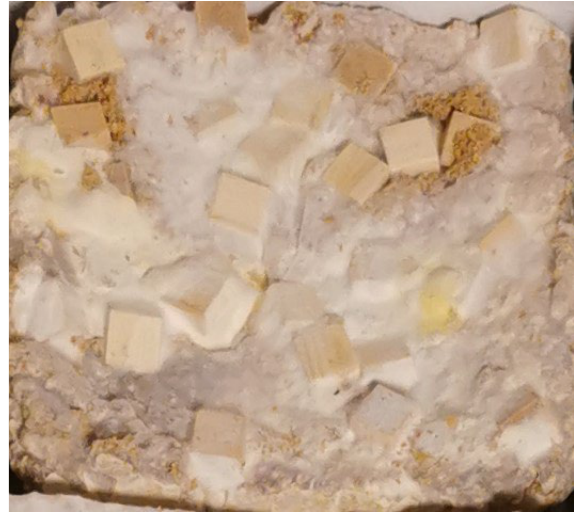
Figure 3. Sample based on hemp mix with wood cubes. Surface: smooth with inclusions; color: off-white, wood inclusions (photo A. Bonenberg).